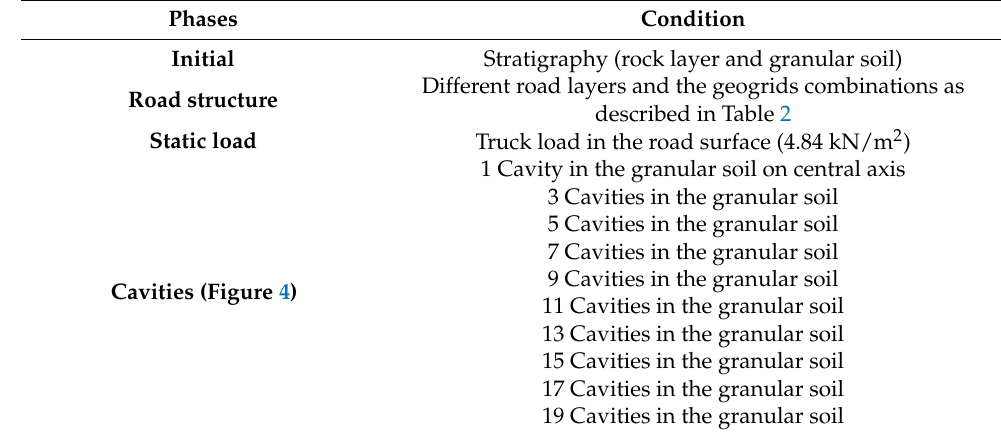
Table 1. Phases in the numerical modelisation.